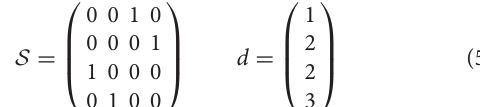
The pair ( S , d ) defines a state of a linear molecule